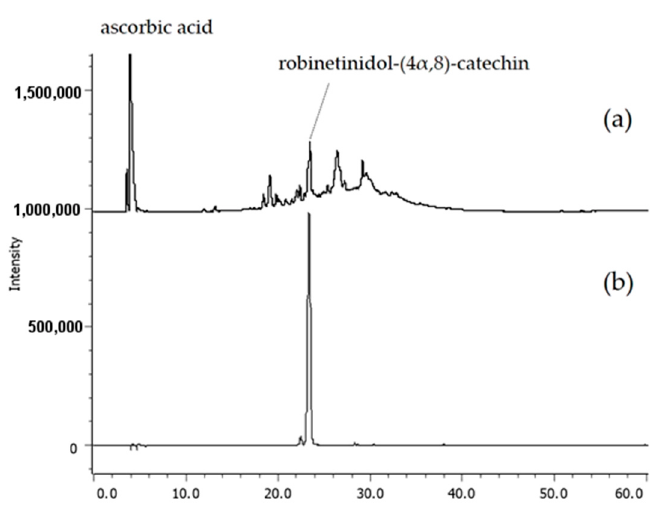
Figure 2. Structure of robinetinidol-(4 α ,8)-catechin.